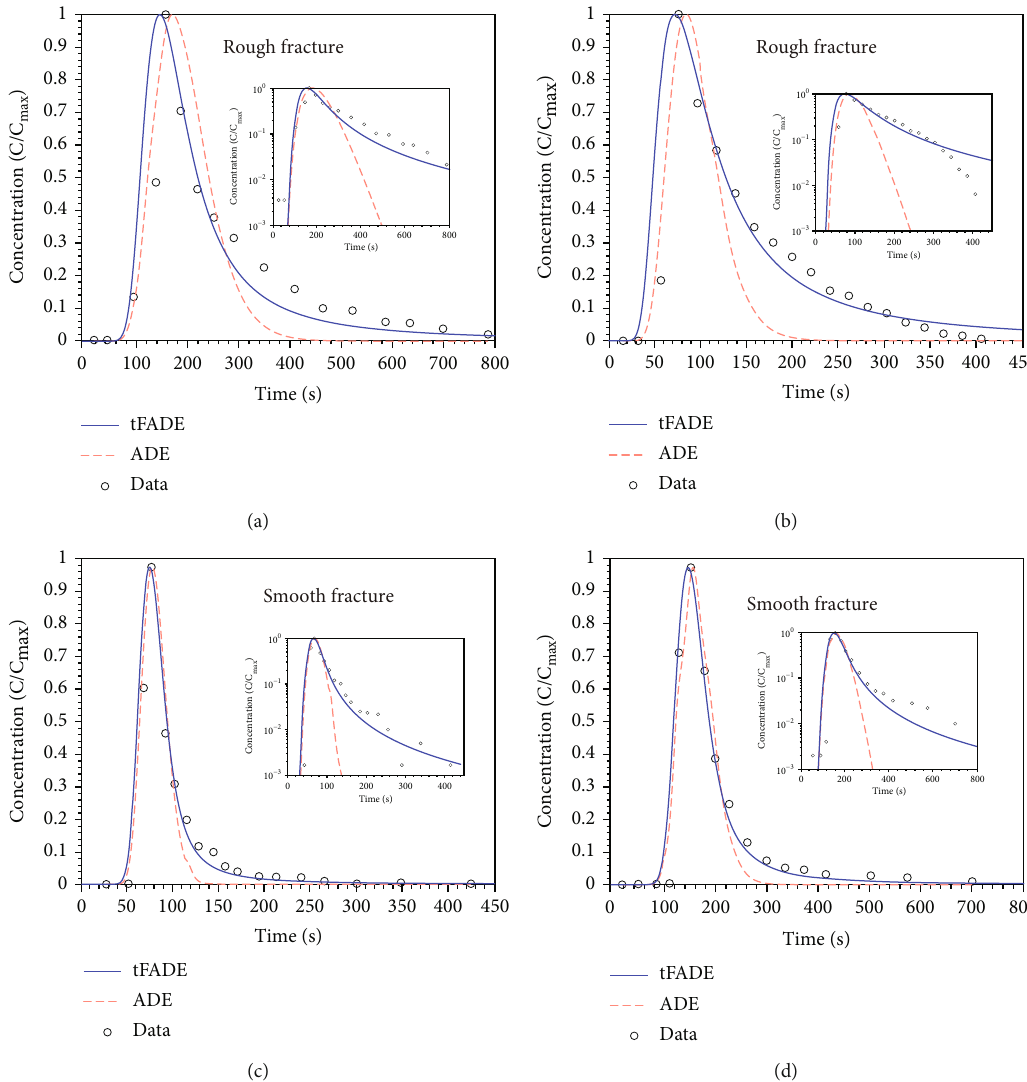
Figure 6: Fitting BTCs for the BBF transport using tFADE and ADE in the rough fracture (a, b) and the smooth fracture (c, d) with the average aperture of 4mm. Table 4: Model errors for the BBF transport in the plexiglass fracture with average aperture of 2 mm. Model ADE tFADE Velocity